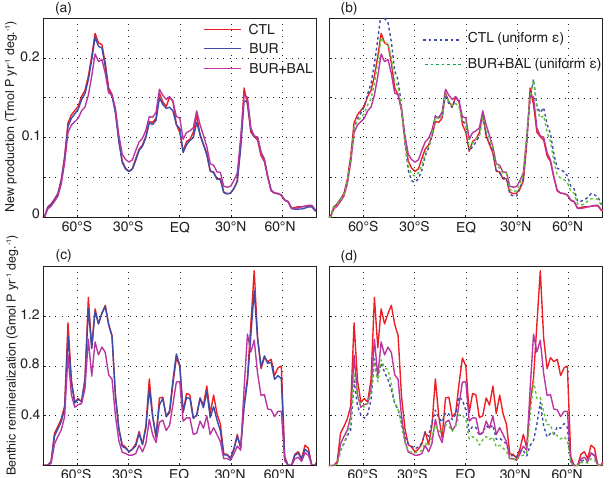
Figure 8. (a) New production by latitude for the CTL, BUR, and BUR+BAL models (averaged over the four different model config- urations). (b) As (a) , but comparing new production rates for the CTL and BUR+BAL models using the standard spatially varying (cid:15) values, and a spatially uniform value of (cid:15) = 4 . 2. (c) As (a) , but showing benthic remineralization below 2000m. (d) As (b) , but for benthic remineralization below